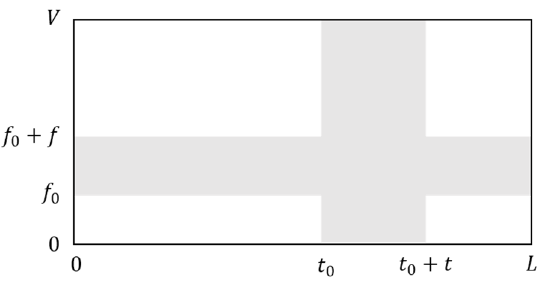
Figure 2. SpecAugment applied to spectrogram. The sections to which frequency masking was applied [ f 0 , f 0 + f ) and time masking was applied [ t 0 , t 0 + t ) are shown in